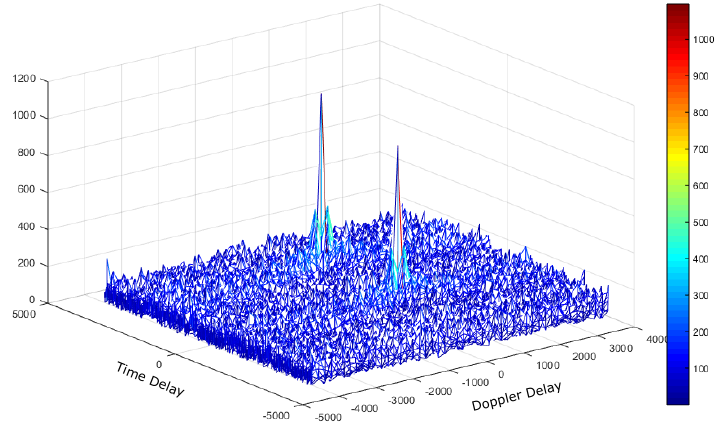
Figure 18. Two nearby scatterers using chirp pulses (MMPP), at − 5 dB SNR.